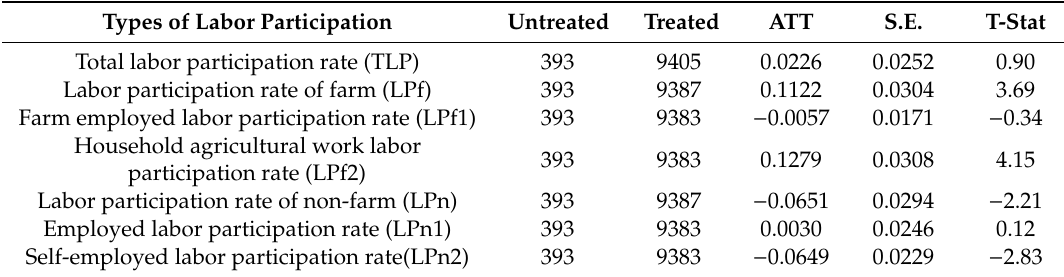
Table 9. ATT of health insurance to the labor participation